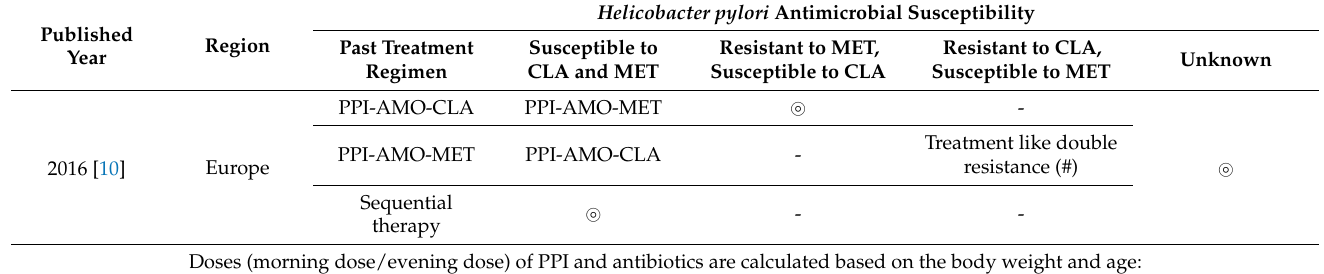
Table 4. Recommended options for second-line therapy of Helicobacter pylori